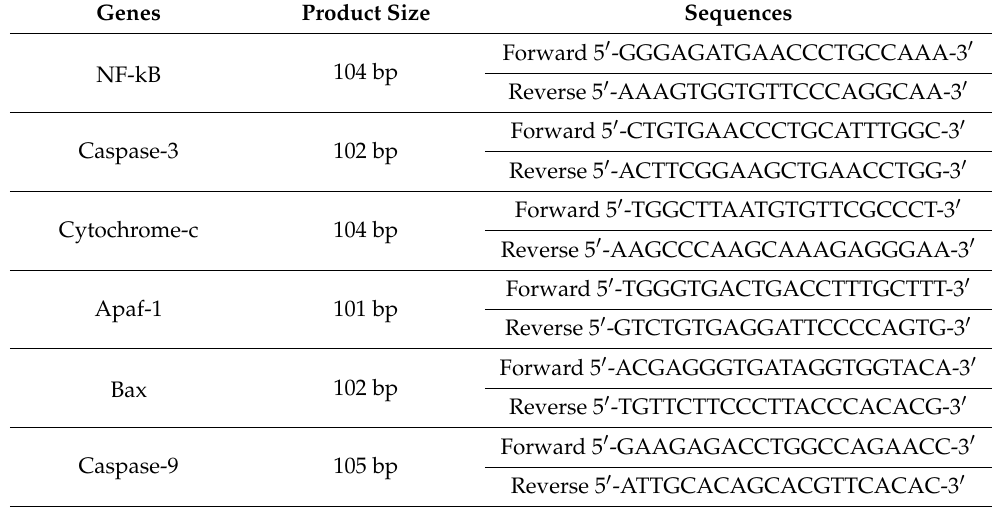
Table 1. List of designed primers used for